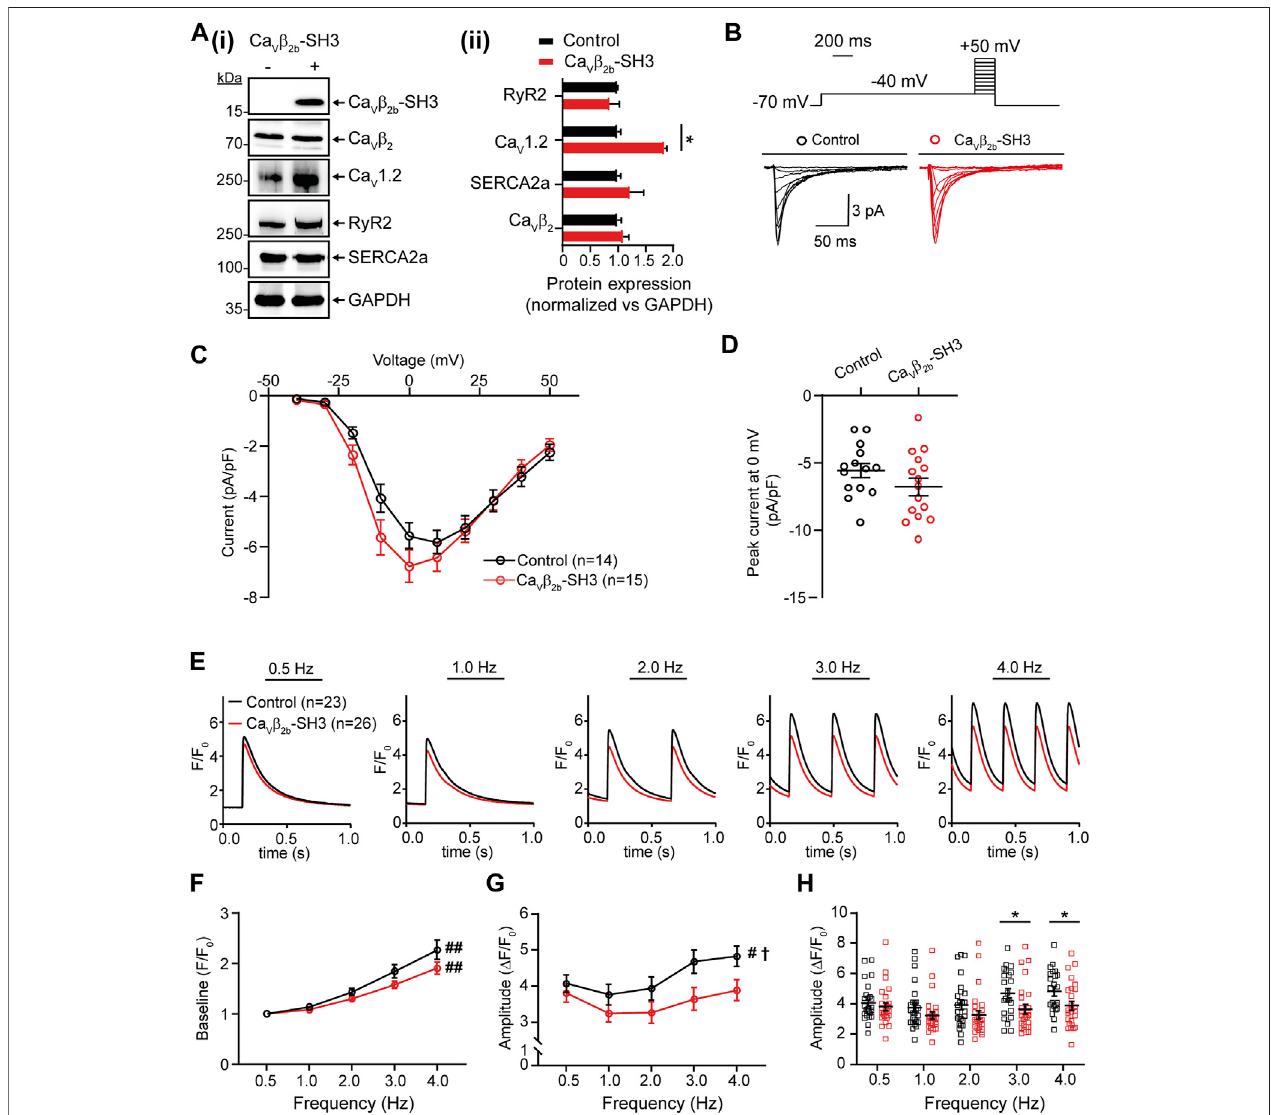
FIGURE 5 | Endogenous L-type Ca 2+ currents and Ca 2+ transients measured at different pacing frequencies in ARCs expressing Ca v β 2b -SH3. (A) Western blot analysis of the expression of Ca v β 2 , Ca v 1.2, RyR2, SERCA2a, and GAPDH in ARCs after Ca v β 2b -SH3 transduction (i) and bar plot of mean values of densitometry analyses from western blots (ii) . The expression of construct Ca v β 2b -SH3, which contains a V5-tag at the C-terminus, was detected using an anti-V5 antibody. The protein expressions in theright panel were normalized vs GAPDH. (B) Voltagestep protocol and representative whole-cell endogenousL-type Ca 2+ current traces of control (black) and Ca v β 2b -SH3-expressing (red) cardiomyocytes. (C) Current-voltage curves of L-type Ca 2+ currents of control (black) and Ca v β 2b -SH3-expressing (red) cardiomyocytes. (D) Scatter plot showing peak L-type Ca 2+ currents at 0 mV in control (black) and Ca v β 2b -SH3-expressing (red) cardiomyocytes. (E) Representative fl uorescence traces of Ca 2+ transients in control (black) and Ca v β 2b -SH3-expressing (red) cardiomyocytes stimulated at pacing frequencies of 0.5, 1.0, 2.0,3.0,and4.0Hz. (F) Diastolic(baseline)Ca 2+ concentrationatthedifferentpacingfrequencies. (G) Ca 2+ transientamplitudesafterbaselinesubtractionatthedifferent pacingfrequencies. (H) ScatterplotshowingtheCa 2+ transientamplitudesforeachcellafterbaselinesubtractionatthedifferentpacingfrequencies.Dataarepresented as mean ± SEM; # p < 0.05 between frequencies (one-way ANOVA); ## p < 0.01 between frequencies (one-way ANOVA); † p < 0.05 between control and Ca v β 2b -SH3- expressing ARCs (two-way ANOVA); * p < 0.05 between groups (unpaired t -test). The cells measured in the electrophysiological and Ca 2+ transient analyses were from three different ARCs preparations. The numbers of cells per group measured in the electrophysiological experiments were: control, n (cid:2) 14 and Ca v β 2b -SH3-expressing cardiomyocytes, n (cid:2) 15. For Ca 2+ transient analysis were measured 23 and 26 cells from control and Ca v β 2b -SH3-expressing, respectively. ARCs, adult rat cardiomyocytes; RyR2, ryanodine receptor 2; SERCA2a, sarcoplasmic reticulum-Ca 2+ ATPase 2a.